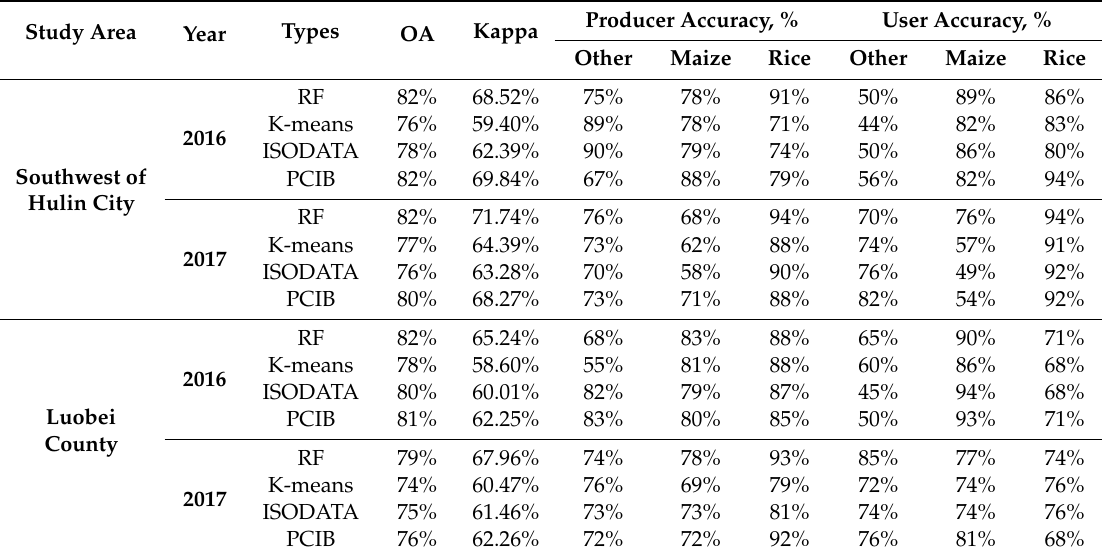
Table 8. Accuracy analysis of di ff erent classification